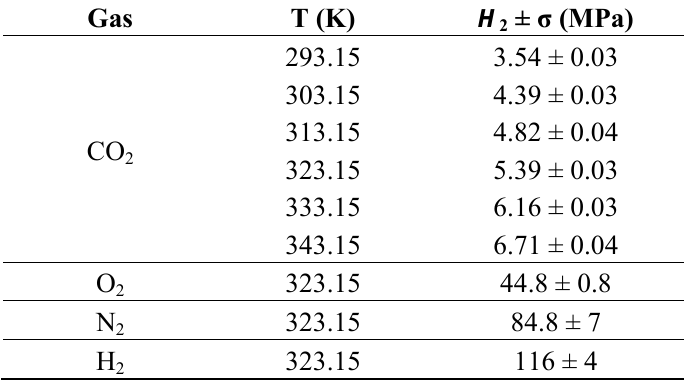
Table 3. Henry’s constants H temperature T and zero pressure a .